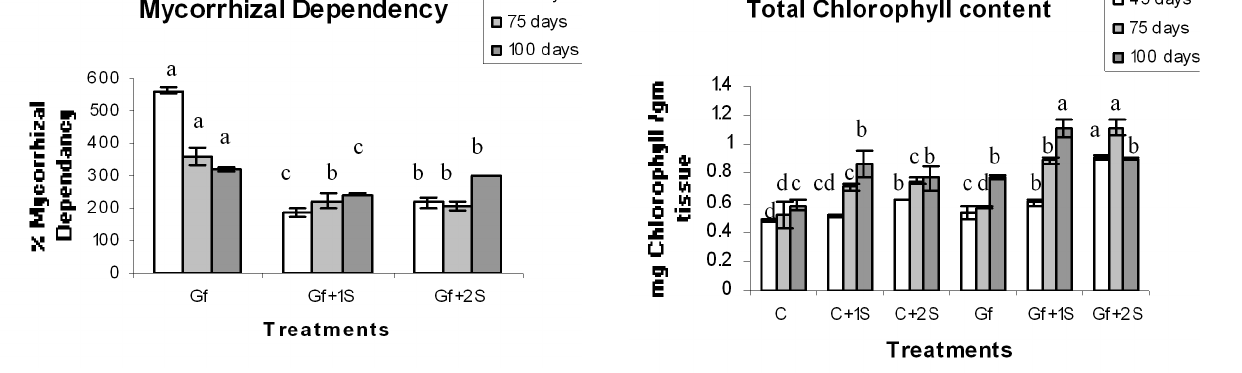
Fig. 1. Mycorrhizal dependency in Gmelina arborea Roxb inoc- ulated with Glomus fasciculatum after 45, 75 and 100 days after AM inoculation